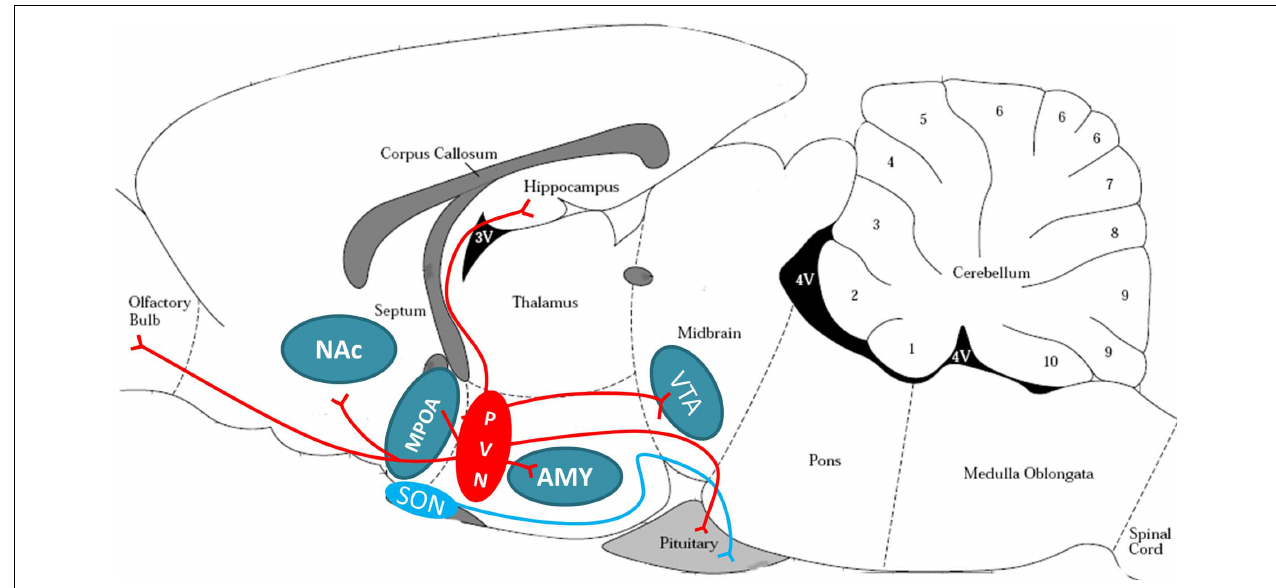
intra-PVN release), and maternal circuitry (MPOA/BNST and OB), and are believed to be critical for appropriate social interactions. PVN, paraventricular nucleus of hypothalamus; SON, supraoptic nucleus of hypothalamus;VTA, ventral tegmental area; NAc, nucleus accumbens; AMY, amygdala; MPOA, medial preoptic area of the hypothalamus; OB, olfactory bulb. Brain schematic adapted from Paxinos andWatson